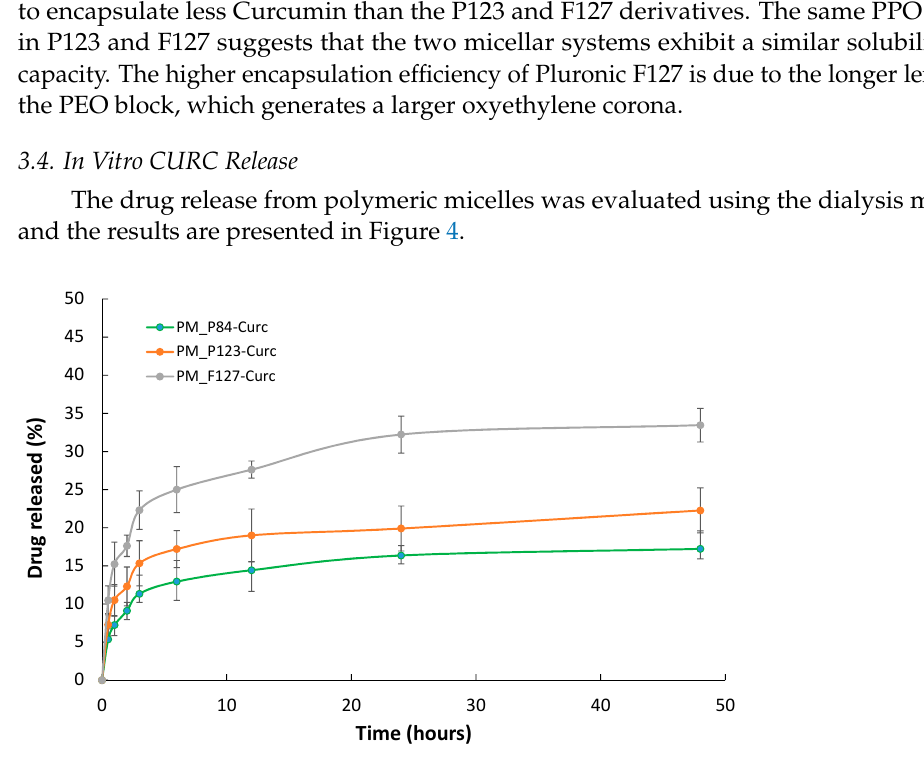
Figure 4. The CURC release profile from micellar solutions of various Pluronic derivatives. Data expressed as the mean value and standard deviation of three